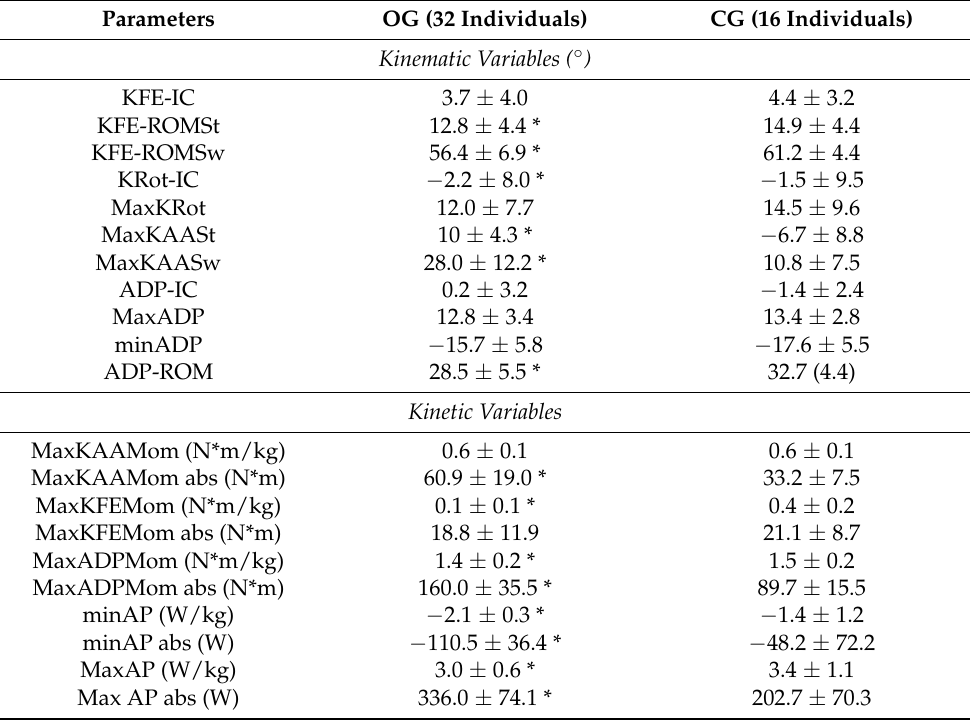
Table 2. Kinematic and kinetic variables, with mean (SD) in OG and CG. * p <